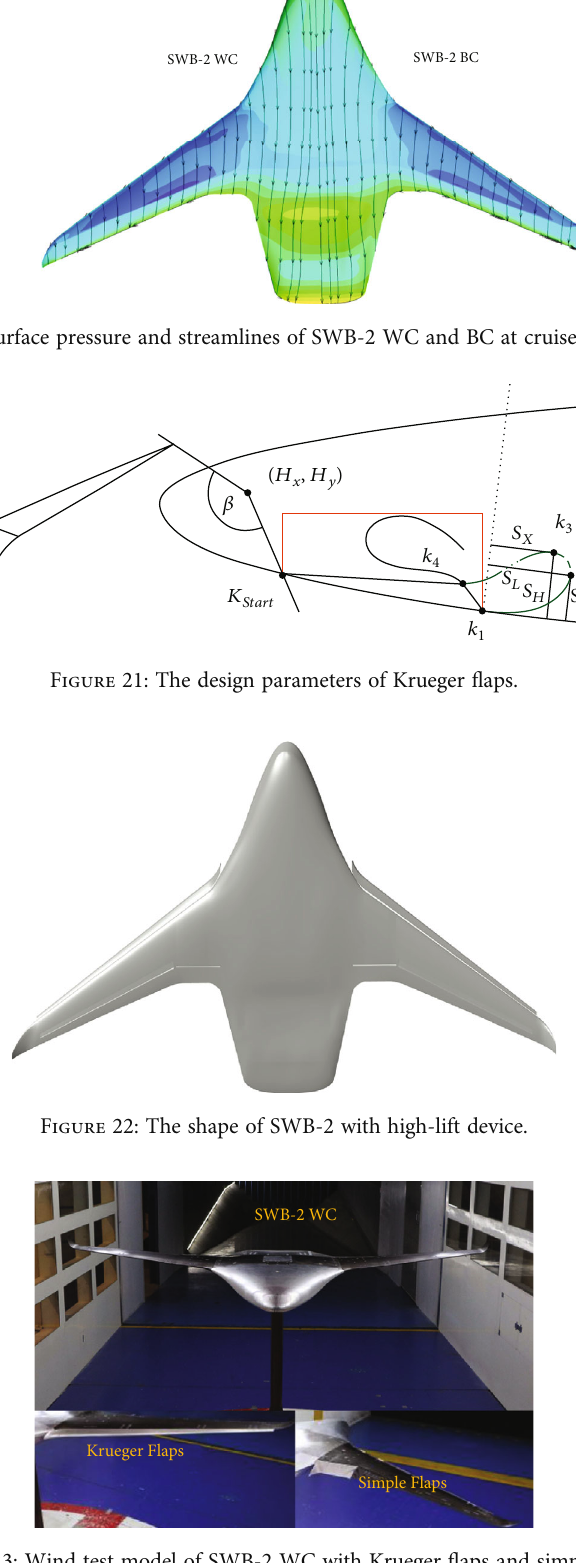
Figure 23: Wind test model of SWB-2 WC with Krueger fl aps and simple fl